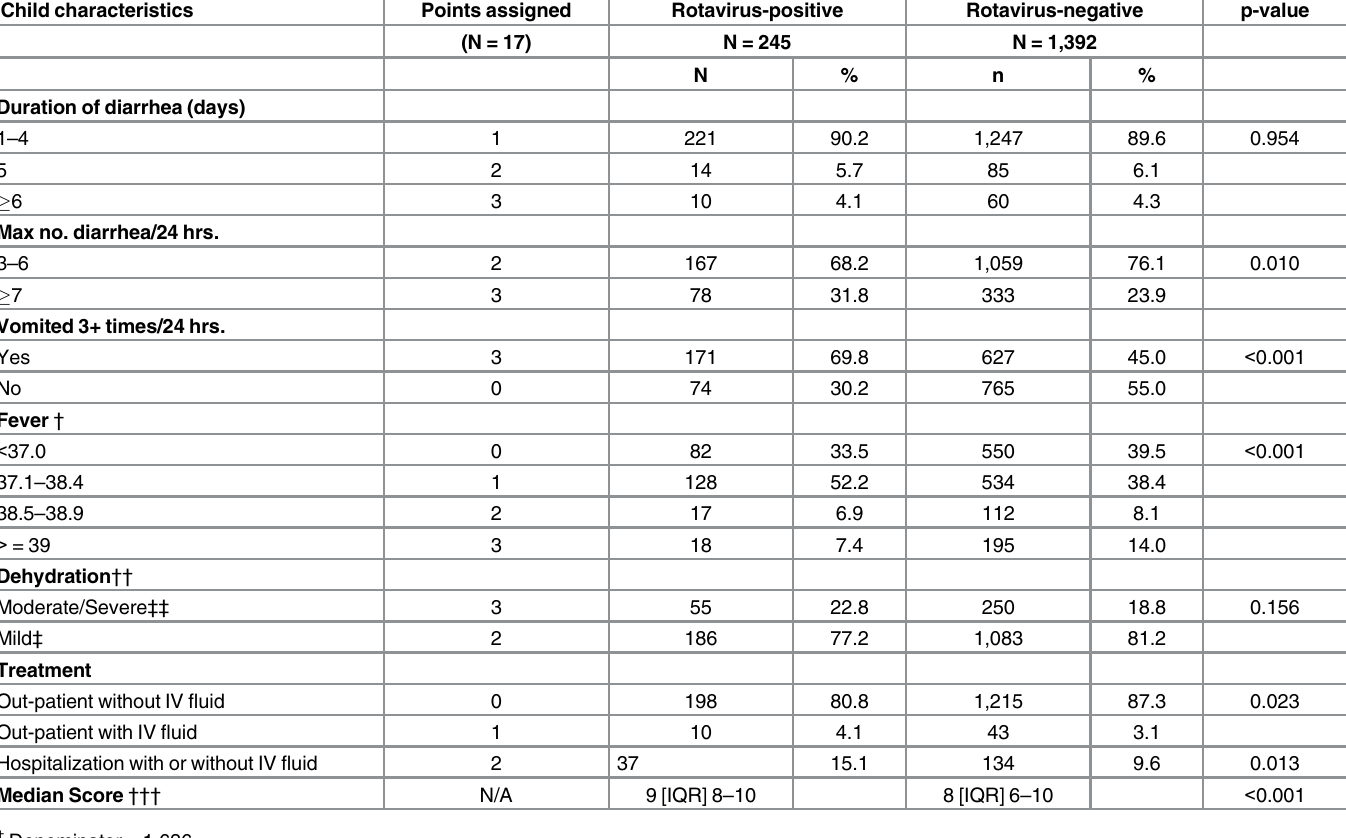
Table 4. Numerical (GEMS modified) scoring system for severity of diarrhea among rotavirus-positive and negative children with non-dysenteric MSD, western Kenya, January 31, 2008-September 30, 2012. Child